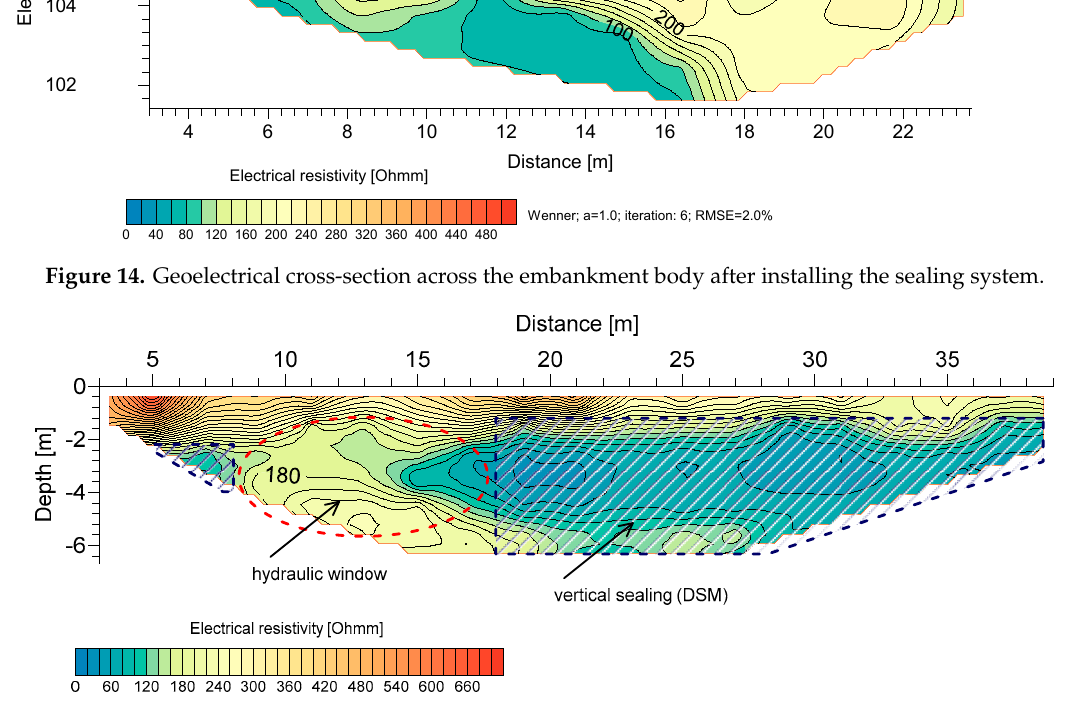
Figure 15. Geoelectrical cross-section across the embankment after installing the sealing system (view of vertical sealing and hydraulic window in the embankment body).